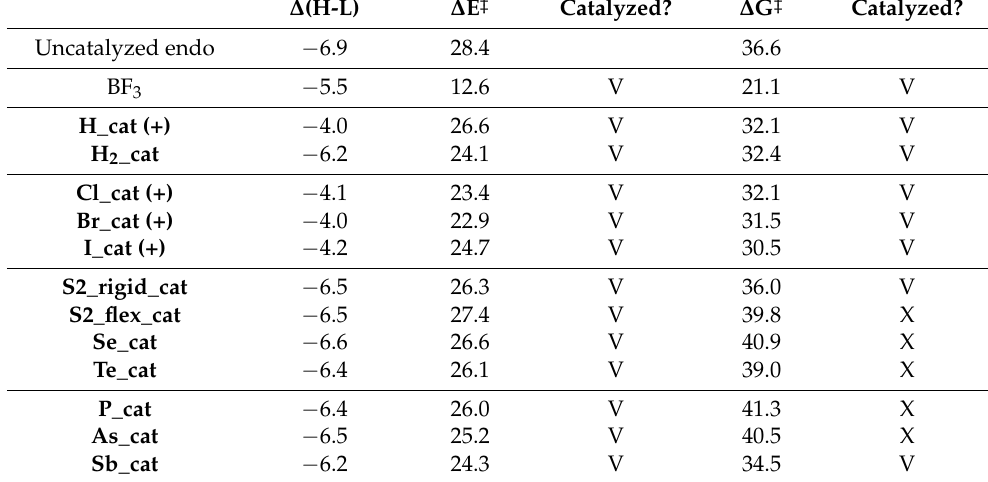
Table 3. Activation energies ∆ E ‡ at 0 K and Gibbs free activation energies ∆ G ‡ at 298.15 K in kcal mol − 1 for the endo DA reaction between benzaldehyde and 1,3-dimethyl 2,3-butadiene and the HOMO-LUMO energy gap, ∆ (H-L), in eV for the diene and dienophile. The activation barriers are calculated relative to the most stable reactant complex, R1_cat + R2 or R1_cat_R2, if stable and to the separate reagents if not stable. V denotes that reaction is catalyzed, X when it is